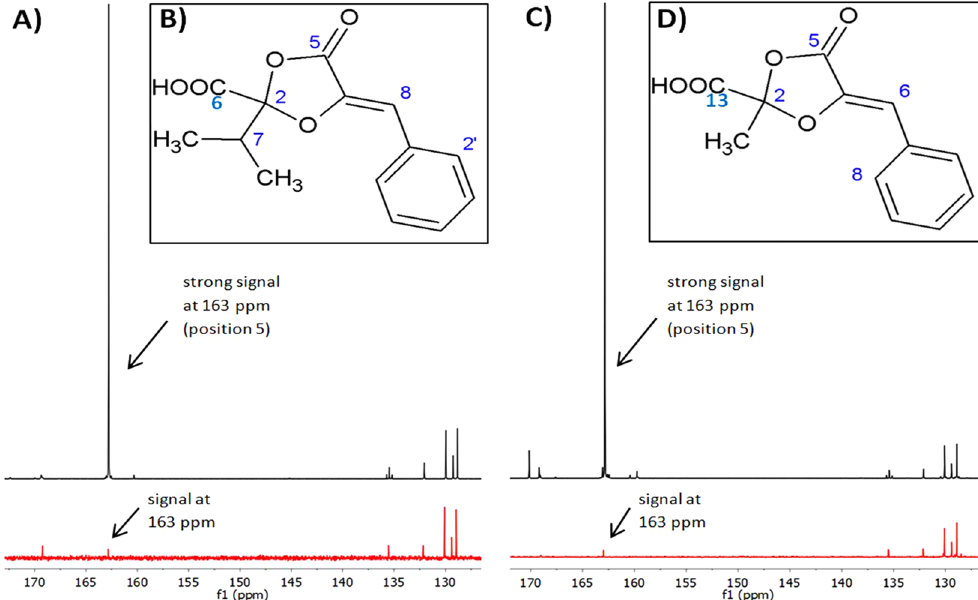
Figure 4. Spectra of 13 C NMR measurement of 13 C-labelled and non-labelled guignardic acid and alaguignardic acid with structural formulas. ( A , C ) A strong signal was detected at 163 ppm (black) in the NMR spectrum of guignardic acid, respectively, alaguignardic acid, whereas this signal with lower intensity was detectable (red) within the NMR spectrum of the compounds without labelling. This is significant for an enrichment of 13 C at the C-5 position in guignardic acid, respectively, alaguignardic acid. ( B ) Structural formulae of guignardic acid. ( D ) Structural formula of alaguignardic